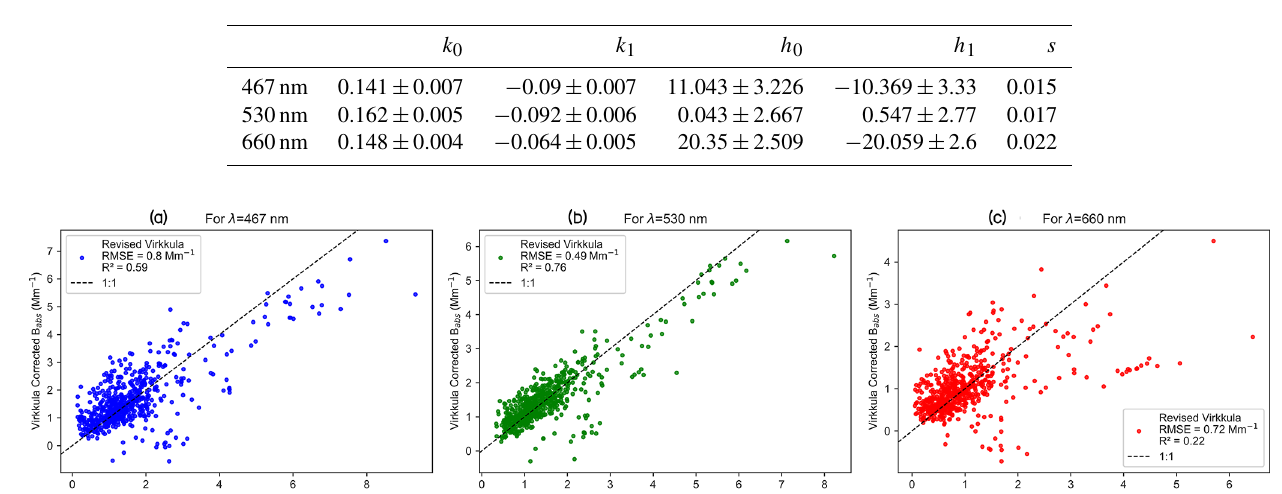
Table 2. Revised parameters for the Virkkula equation computed using the SGP dataset.